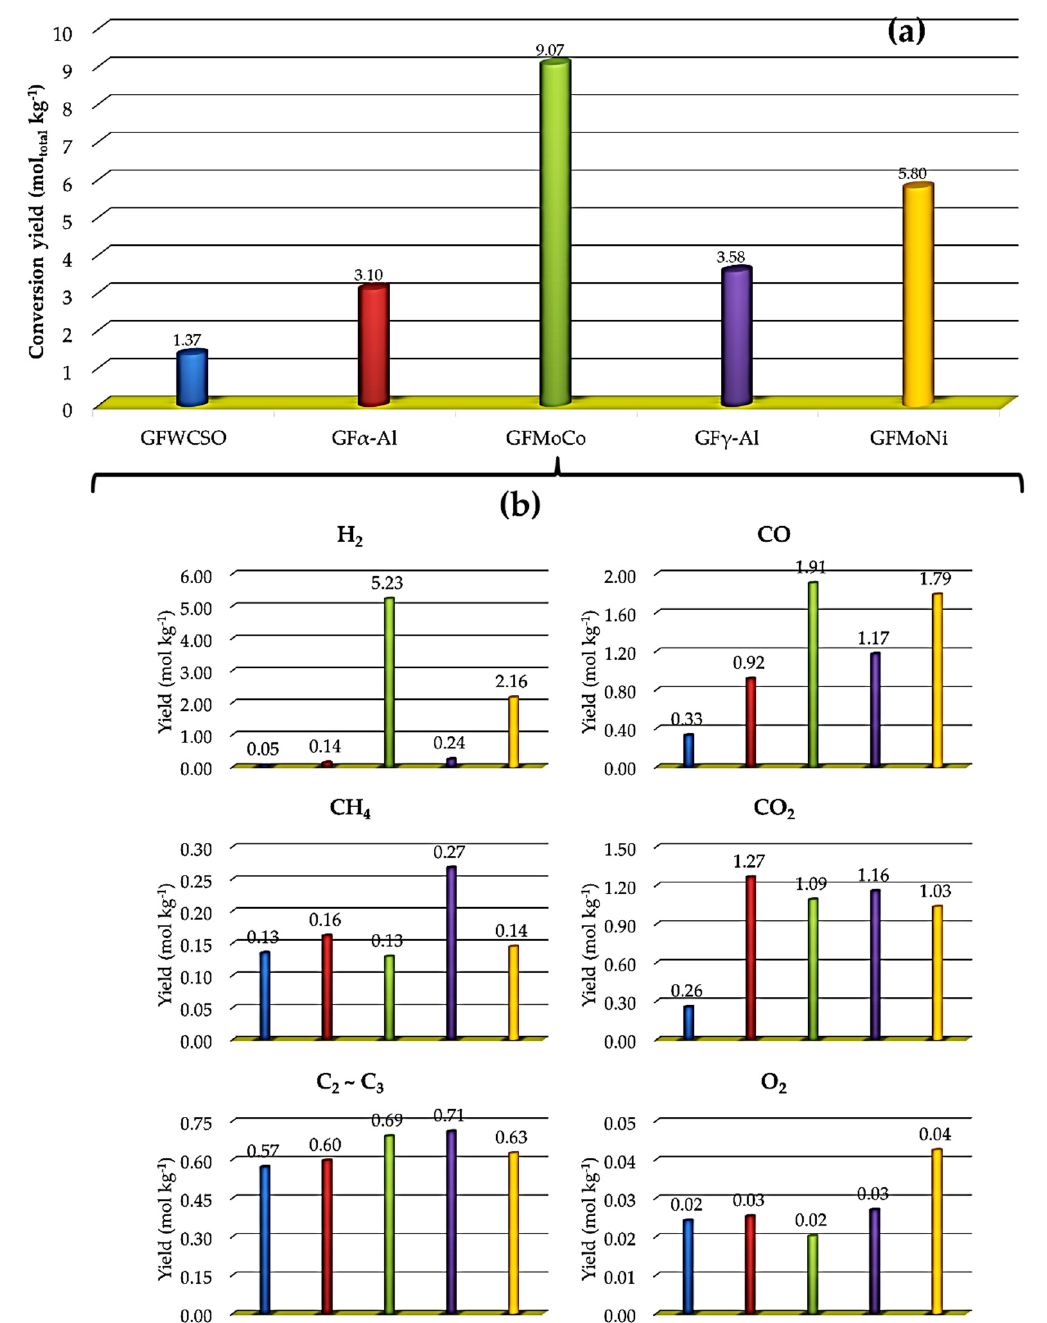
Figure 9. ( a ) Absolute matter amount of gas fractions produced in each micropyrolysis experiment; ( b ) Absolute matter amount of the components that represent the product of gas fraction. Gas compositions are given on a N 2 -free basis.